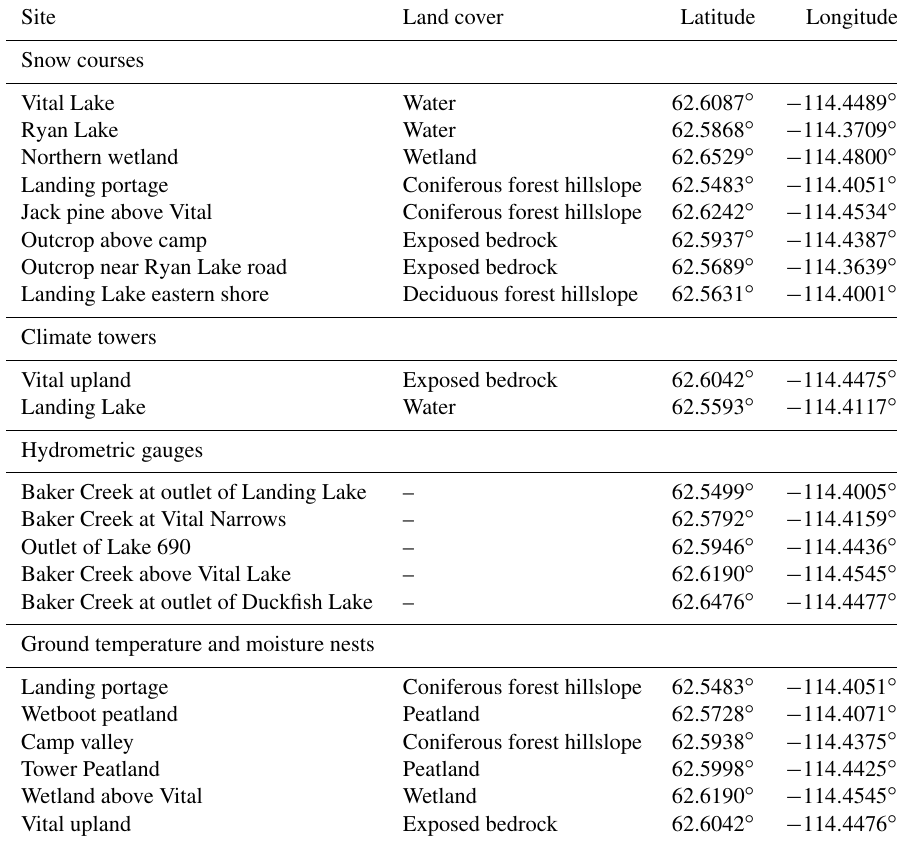
Table 3. List of monitoring locations in the Baker Creek Research